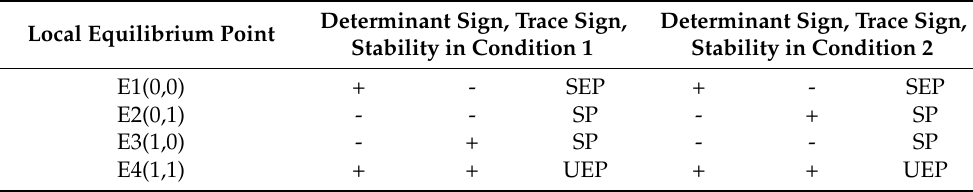
Table 2. Local equilibrium point stability analysis. Determinant Sign, Trace Sign, Local Equilibrium Point Stability in Condition 1